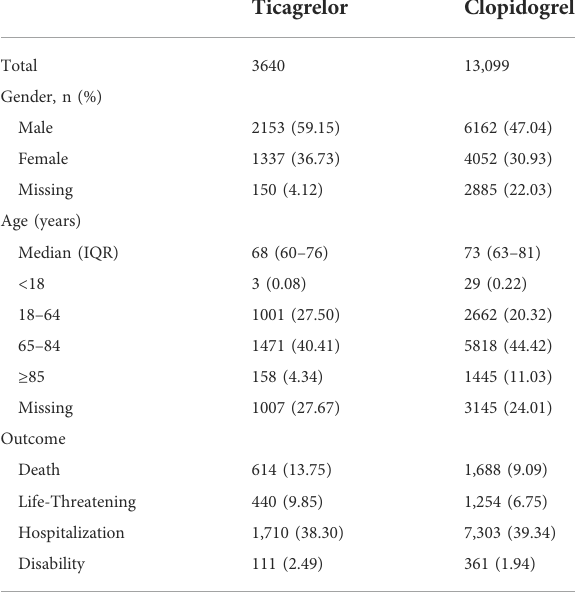
TABLE 6 Clinical information associated with hemorrhagic